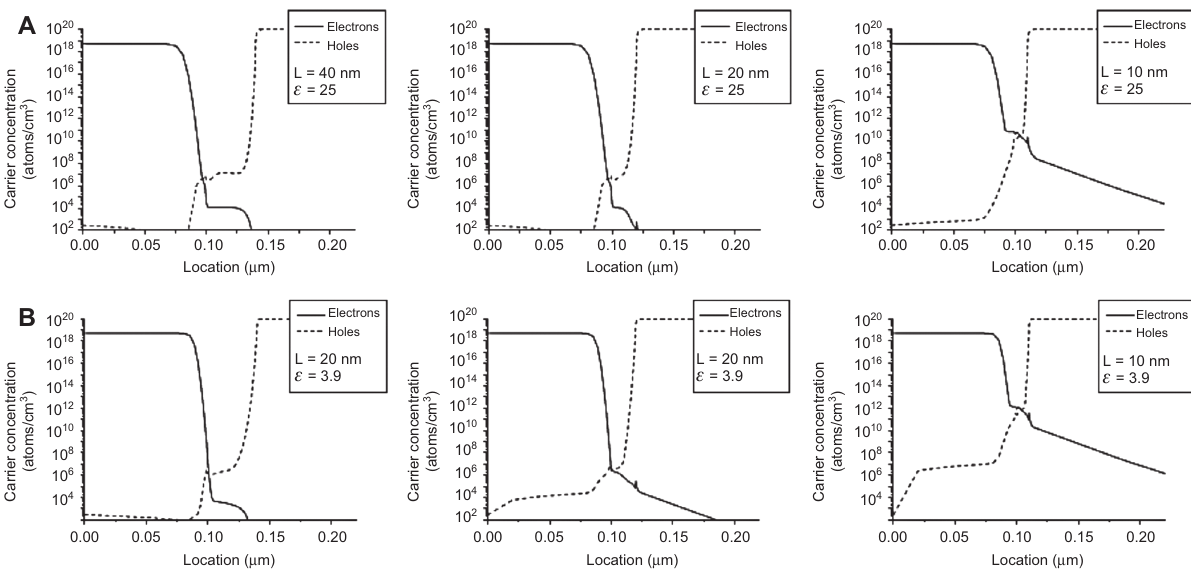
Figure 13 Electron and hole concentrations of the cross-section of a TFET using different gate dielectrics, (A) ε = 25 and (B) ε = 3.9; there is no interfacial oxide layer within the high- κ gate dielectric stacks. With the scaling of channel length, the depleted regions become narrower and less defined. With channel length = 10 nm, devices with both types of gate dielectrics are showing Zener breakdown (electron tunneling) at OFF-state, although the high- κ device shows a small advantage of showing a lower carrier concentration in the intrinsic region under the gate. Reprinted from Ref. [16], with permission, from Elsevier.